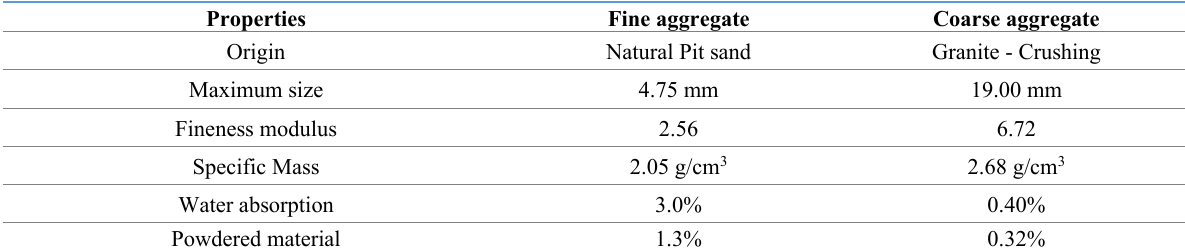
Table 3. Characteristics of the aggregates.